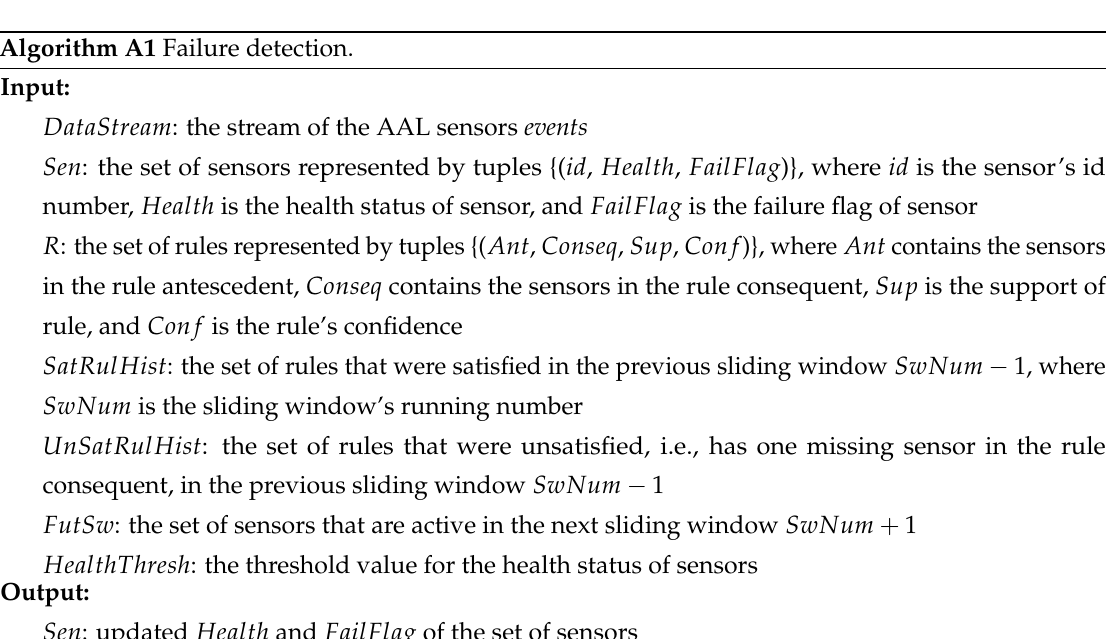
Algorithm A1 Failure